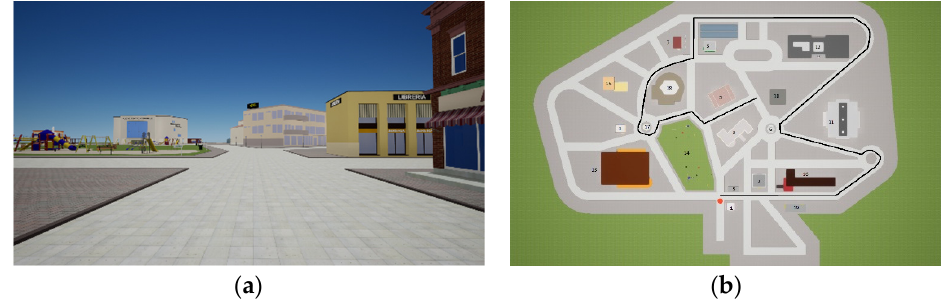
Figure 1. Example route-retracing screenshot ( a ) and sketch map (not shown to participants) with landmarks and the route learned ( b ).